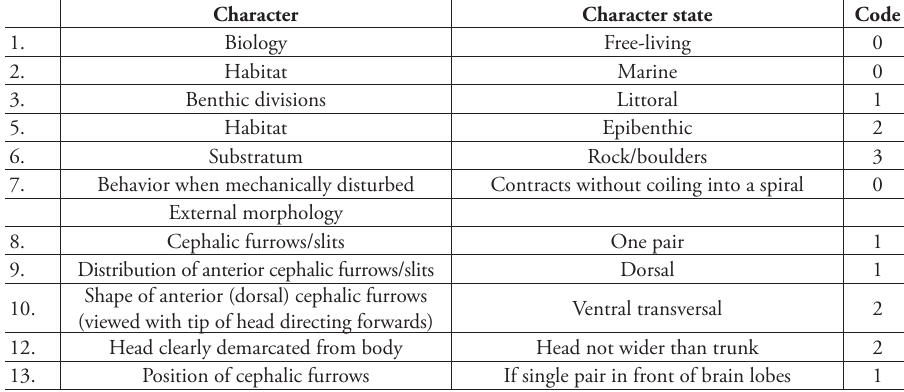
Table 3. Character checklist. List of external characters that could be checked in order to provide a spe- cies description with comparable characters. Modified from Sundberg et al.